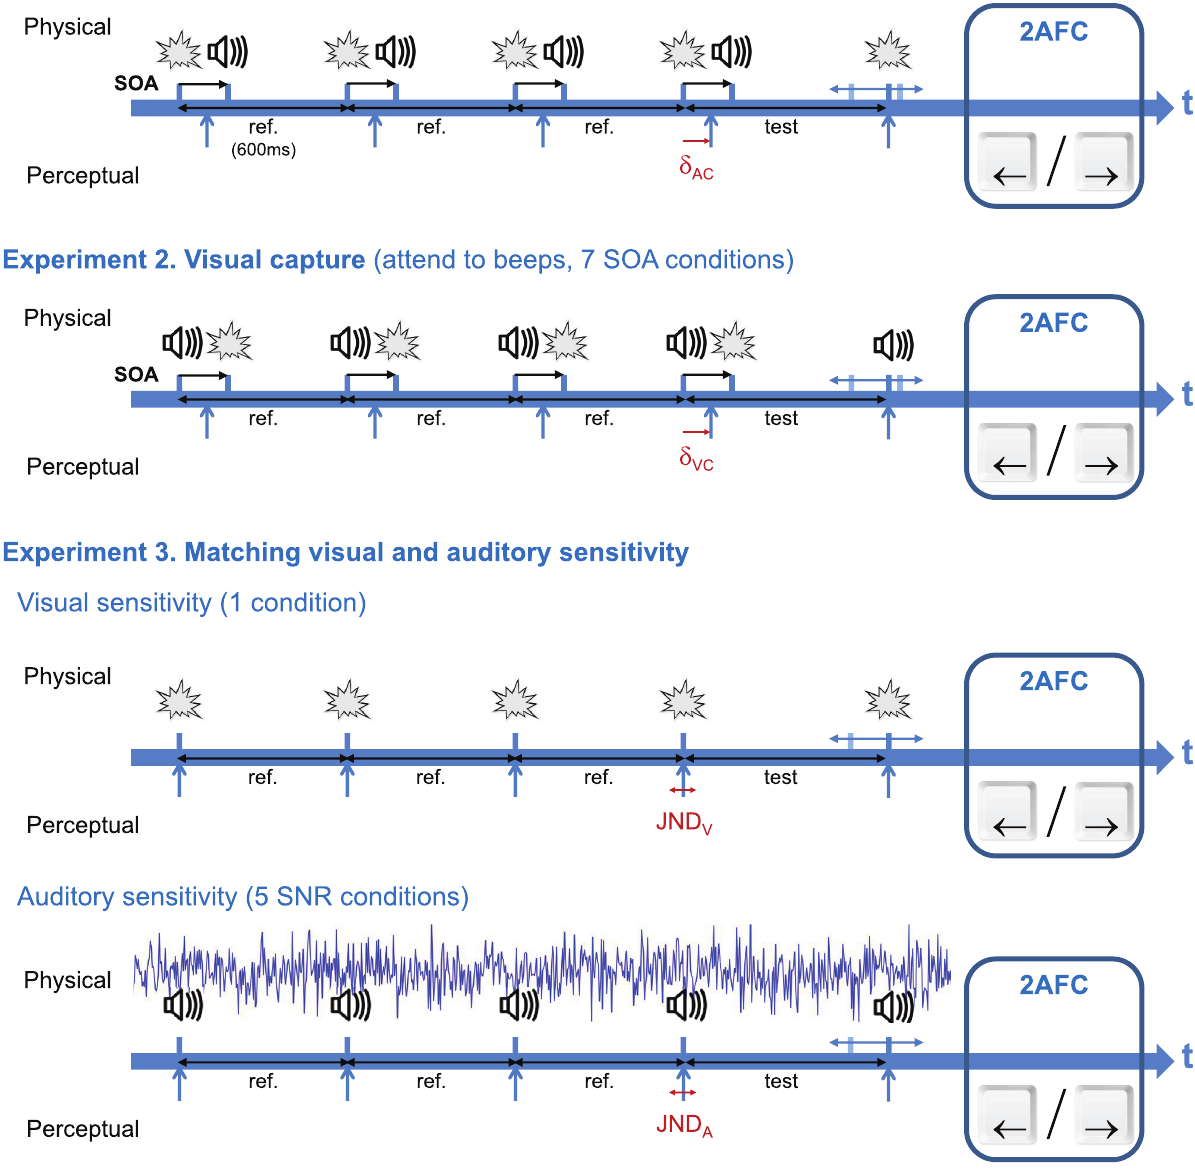
Fig 2. Task timelines of the experimental conditions. In Experiment 1 , participantssaw 4 beep-flashpairs regularlyspaced in time definingthree perceivedintervals(referenceof 600ms), followedafter a variabledurationby a 5 th flash (test interval). The task was to comparein a 2AFC the durationof the test interval with that of the reference intervals, while attending only to the flashes. The SOA betweenthe flash and the beep of each pair was one of the following:–200, –80, –40, 0, +40, +80 and +200ms (positivewhen beep first). In the converse Experiment 2 , participantshad to attend to the beeps and the 5 th event was a beep (positiveSOA when flash first). The auditory capture of visual flashes and the visual capture of auditoryflashes produceperceptual time shifts δ AC and δ VC measured respectivelyin experiment 1 and 2. Experiment 3 was designedto determine for each participant the signal-to-noise ratio (SNR) that impairedthe auditory time-sensitivity (JND A ) so that it nearly matched the visual time-sensitivity (JND V ). JND V and JND A with beeps embedded in pink noise (5 SNR tested: no noise, +2dB, 0dB, –2dB, –4dB) were measuredin separateconditions.